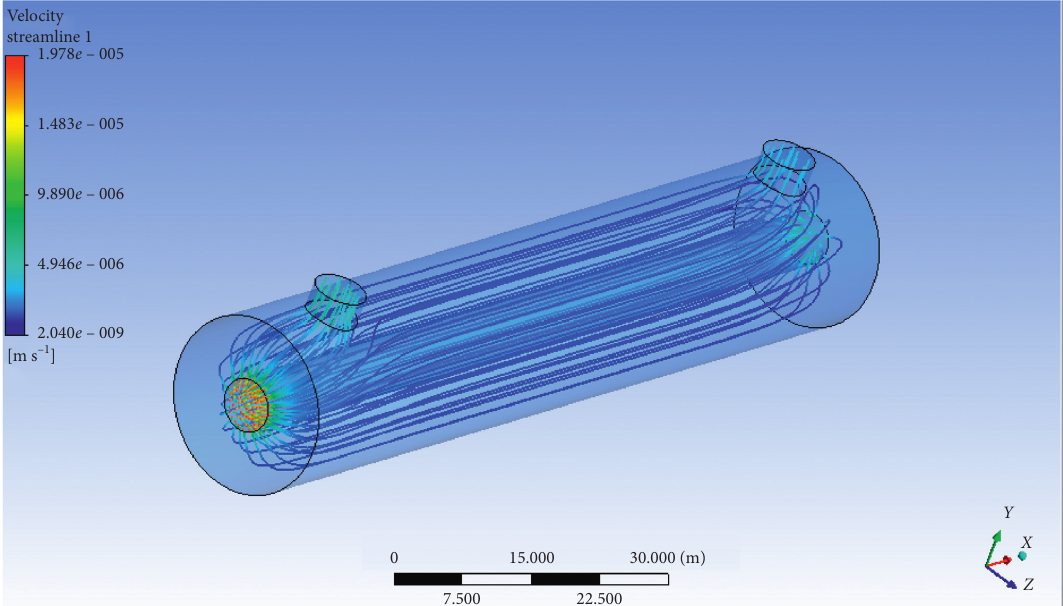
Figure 8: Flow diagram of water in the model.